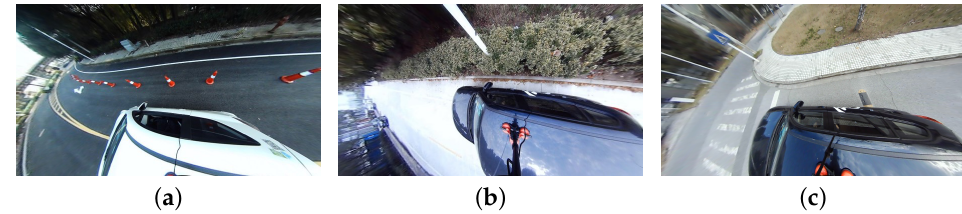
Figure 2. Road scene samples of three classes: ( a ) road scene with obstacles ; ( b ) road scene with curbs ; ( c ) road scene with intersection